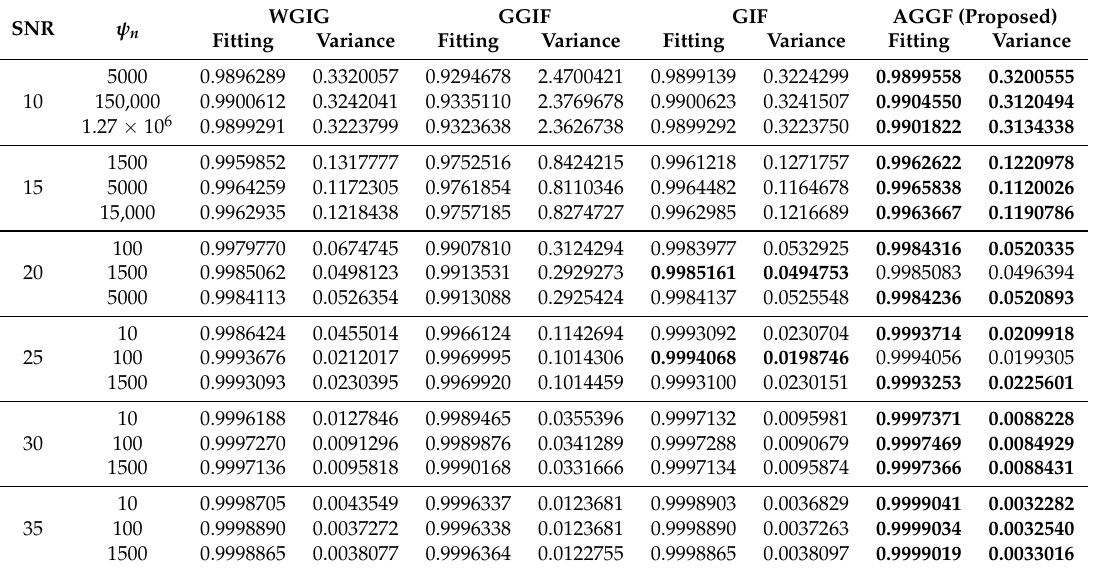
Table 1. Influence of SNR on ψ n for different filtering algorithms, f p = 5G. SNR = 35, ψ n = 69, δ = 4 in WGIF, GGIF and GIF, δ = 3–5 in AGGF; SNR = 30, ψ n = 134, δ = 6 in WGIF, GGIF and GIF, δ = 3–7 in AGGF; SNR = 25, ψ n = 295, δ = 7 in WGIF, GGIF and GIF, δ = 4–8 in AGGF; SNR = 20, ψ n = 1400, δ = 8